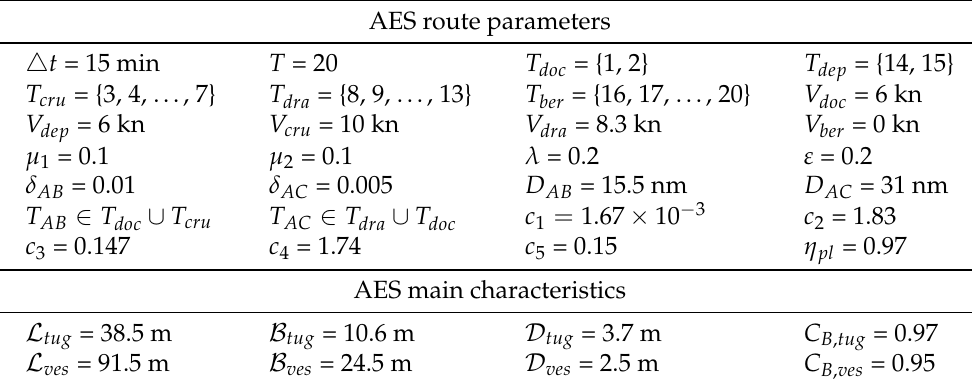
Table 2. AES voyage model parameters.